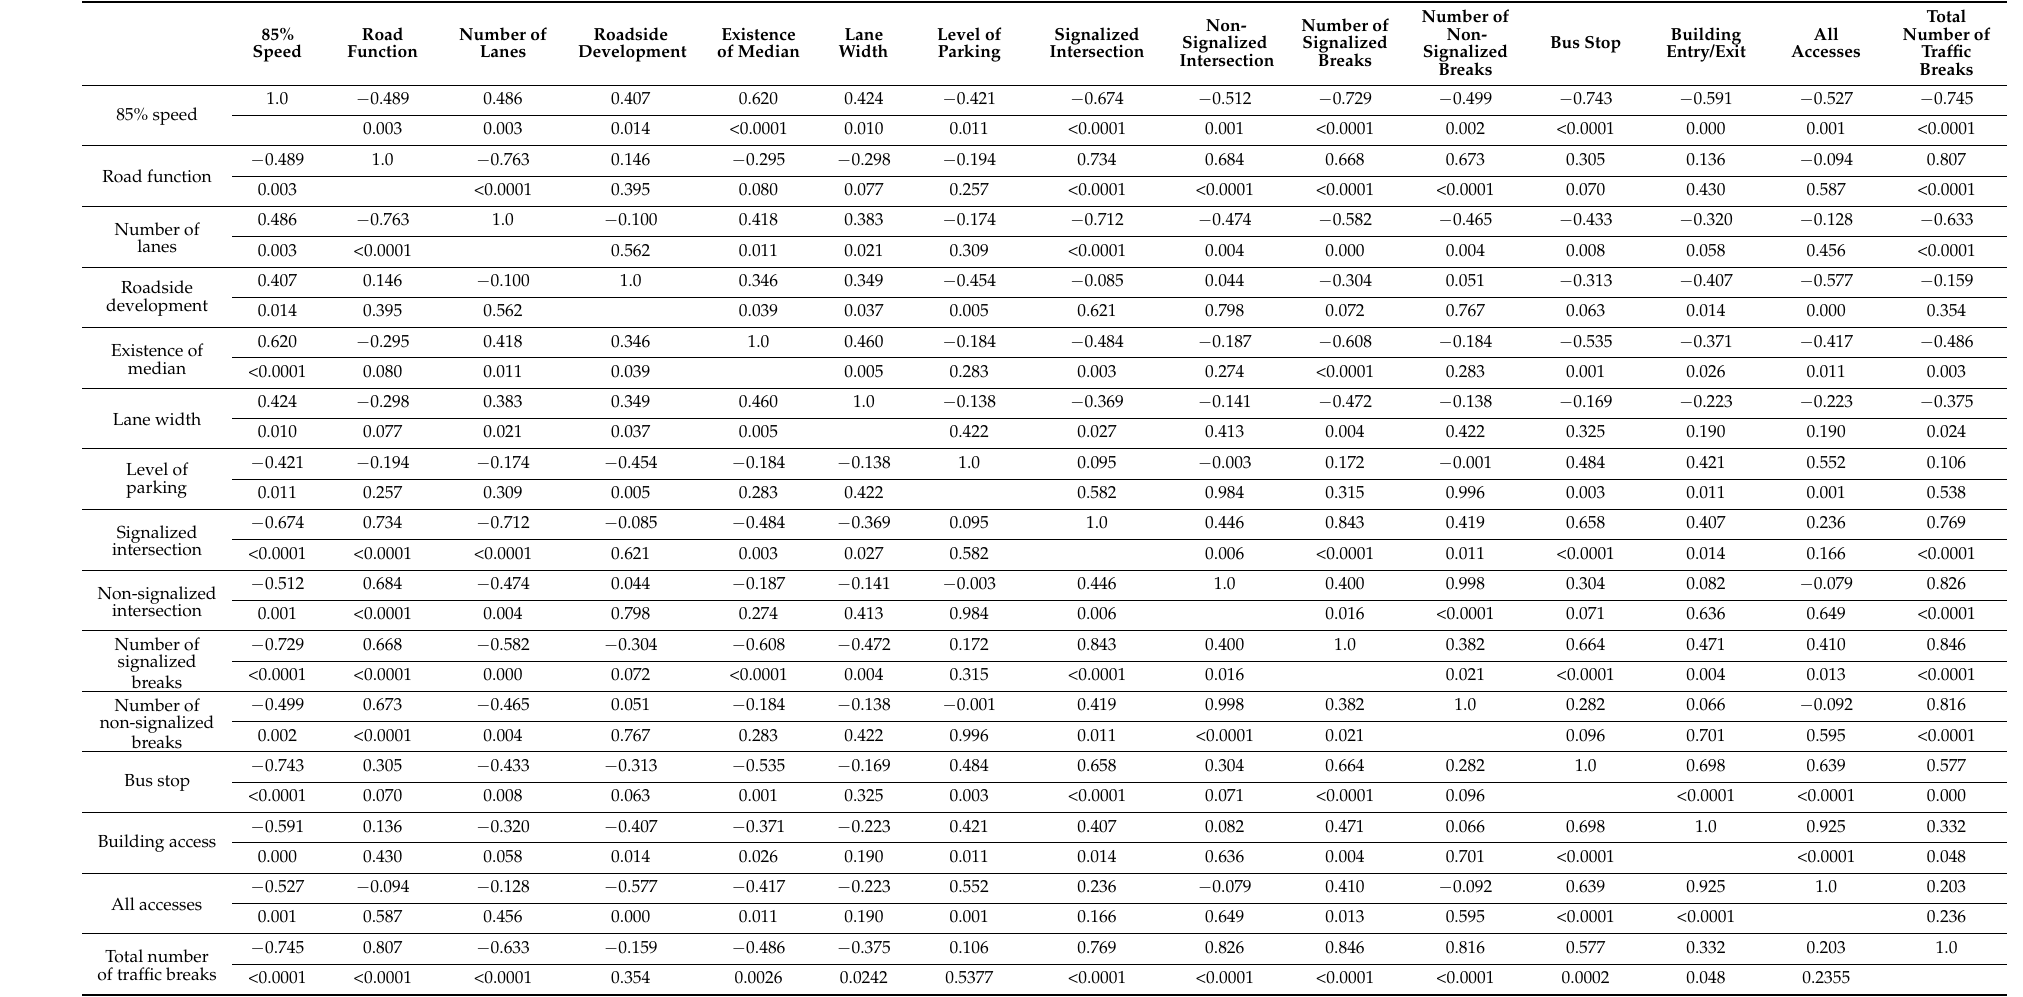
Table 9. Correlation coefficients between the main